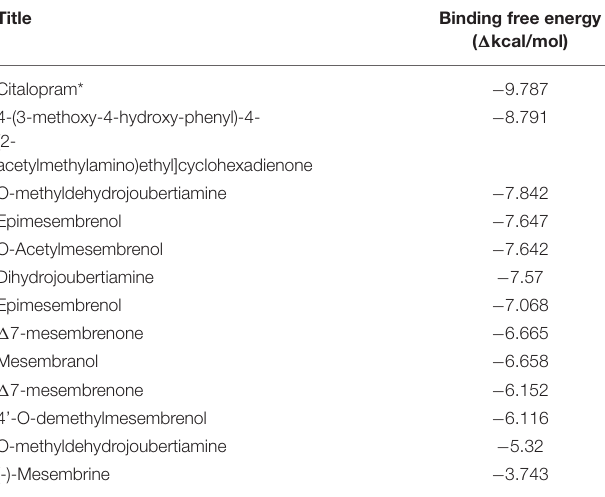
TABLE 4 | Docking scores attained from docking XP scores ( in silico ) on serotonin transporter (5-HT).